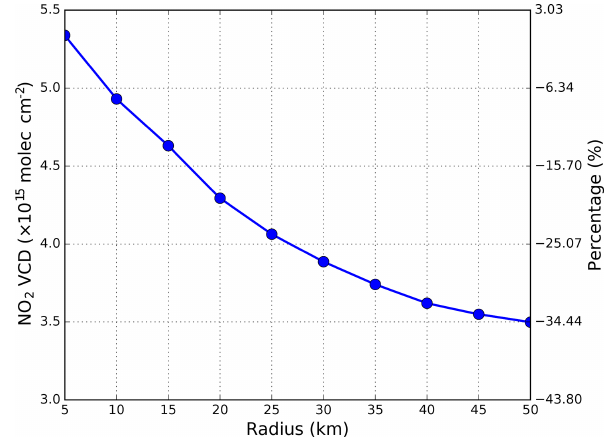
Figure 11. Tropospheric NO 2 VCDs measured by TROPOMI spa- tially averaged with different radii surrounding the MAX-DOAS measurement